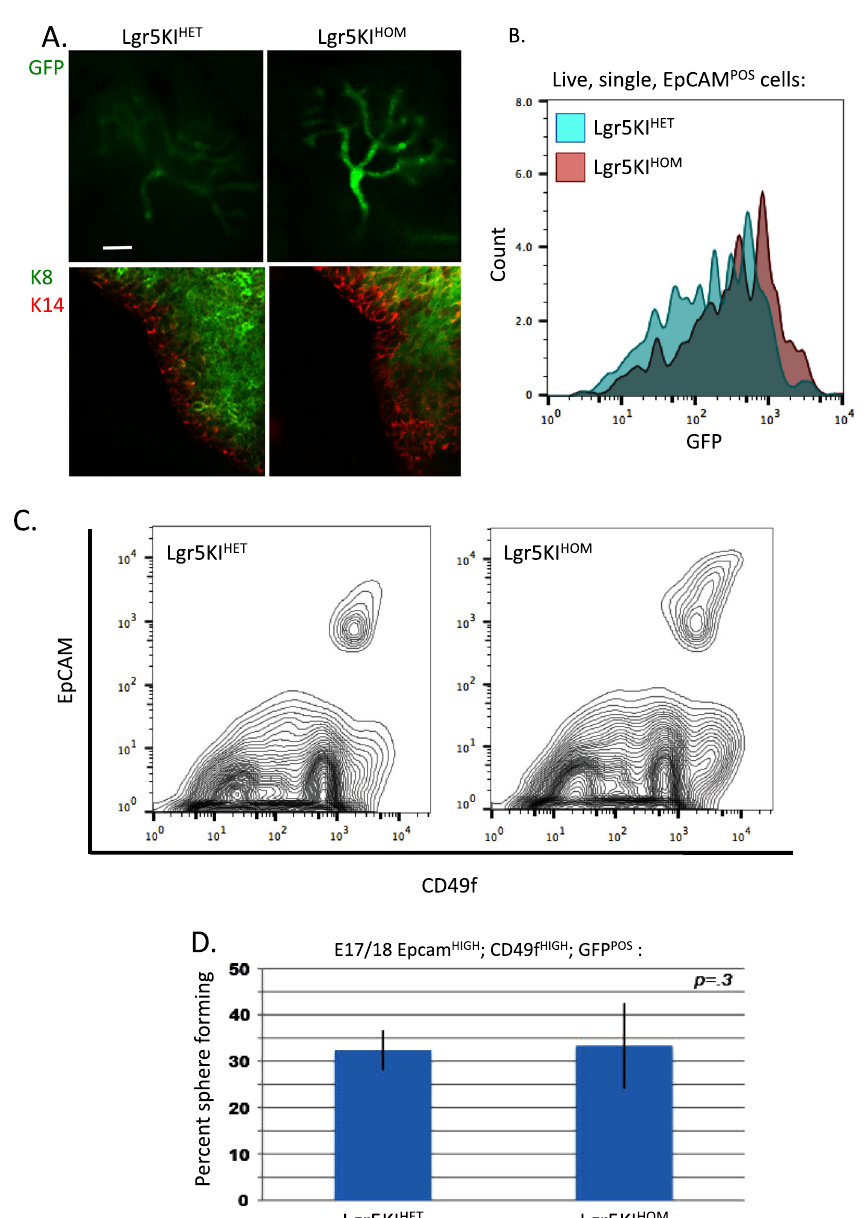
Fig. 4 Analysis of fetal mammary rudiments heterozygous (Lgr5KI HET ) and homozygous (Lgr5KI HOM ) for the Lgr5KI allele. a Fetal mammary rudiments were isolated from Lgr5KI HET and Lgr5KI HOM littermates at stage E18 and stained in whole mount for GFP ( top , bar represents 200 μ M), and Keratin 8 (K8, green ) and Keratin 14 (K14, red , bottom ). b Single-cell suspensions were prepared from Lgr5KI HET and Lgr5KI HOM littermates at stage E18. Live, single, epithelial (EpCAM POS ) cells were analyzed for GFP expression. c Single-cell suspensions were prepared from Lgr5KI HET and Lgr5KI HOM littermates at stage E18. Live, single, epithelial cells were analyzed for EpCAM and CD49f expression by FACS. d Single-cell suspensions were prepared from Lgr5KI HET and Lgr5KI HOM littermates at stage E18. Live, single, EpCAM HIGH ; CD49f HIGH ; GFP POS cells were sorted and plated in to 3D culture containing 2% Matrigel. After 1 week, spheres were quanti fi ed and percent SFCs was determined by the number of spheres counted per the number of cells plated. Percent SFC is reported as averages of biological replicates and error bars represent standard deviations from three separate experiments, each with at least three technical